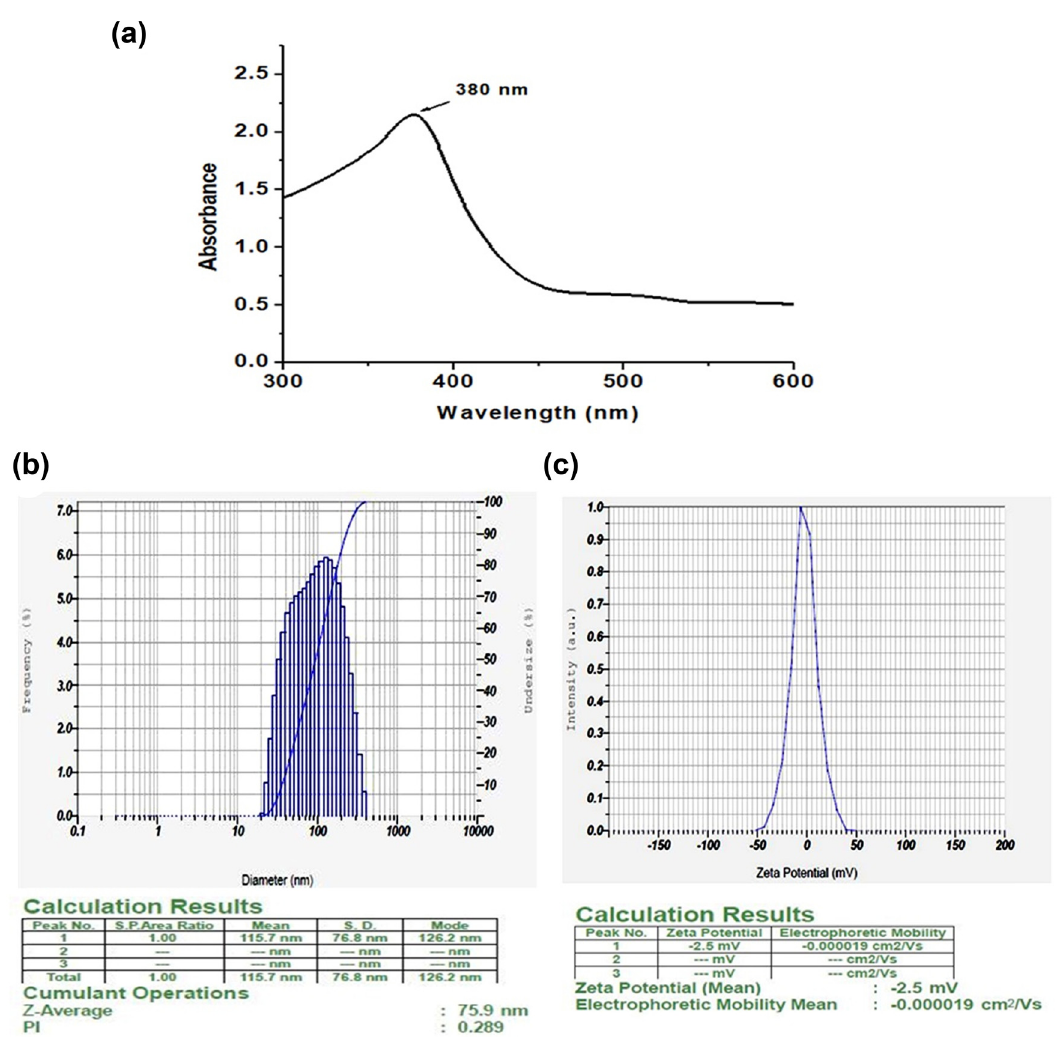
Figure 1: UV - Vis spectral, DLS, and zeta potential analyses of ZnONPs - NC: ( a ) the UV absorption spectrum shows 380 nm; ( b ) the average size of the synthesized nanoparticles was con fi rmed by DLS and found to be 76.8 nm; ( c ) the zeta potential for the ZnONPs - NC was − 2.5